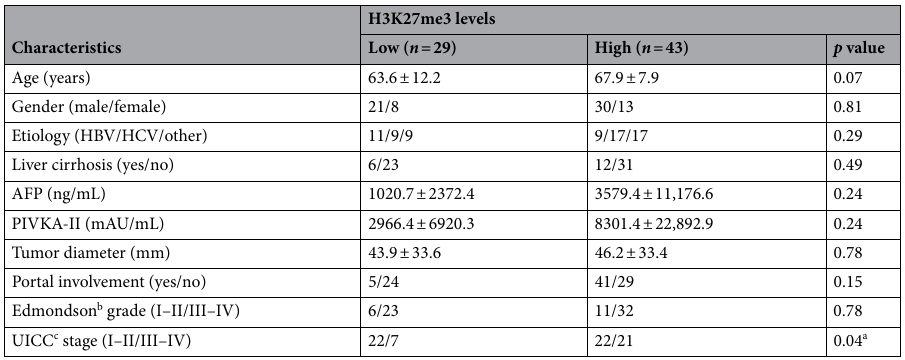
Table 1. Clinicopathological features of H3K27me3 low and H3K27me3 high HCC. a Statistically significant. b Edmondson–Steiner. c International Union Against